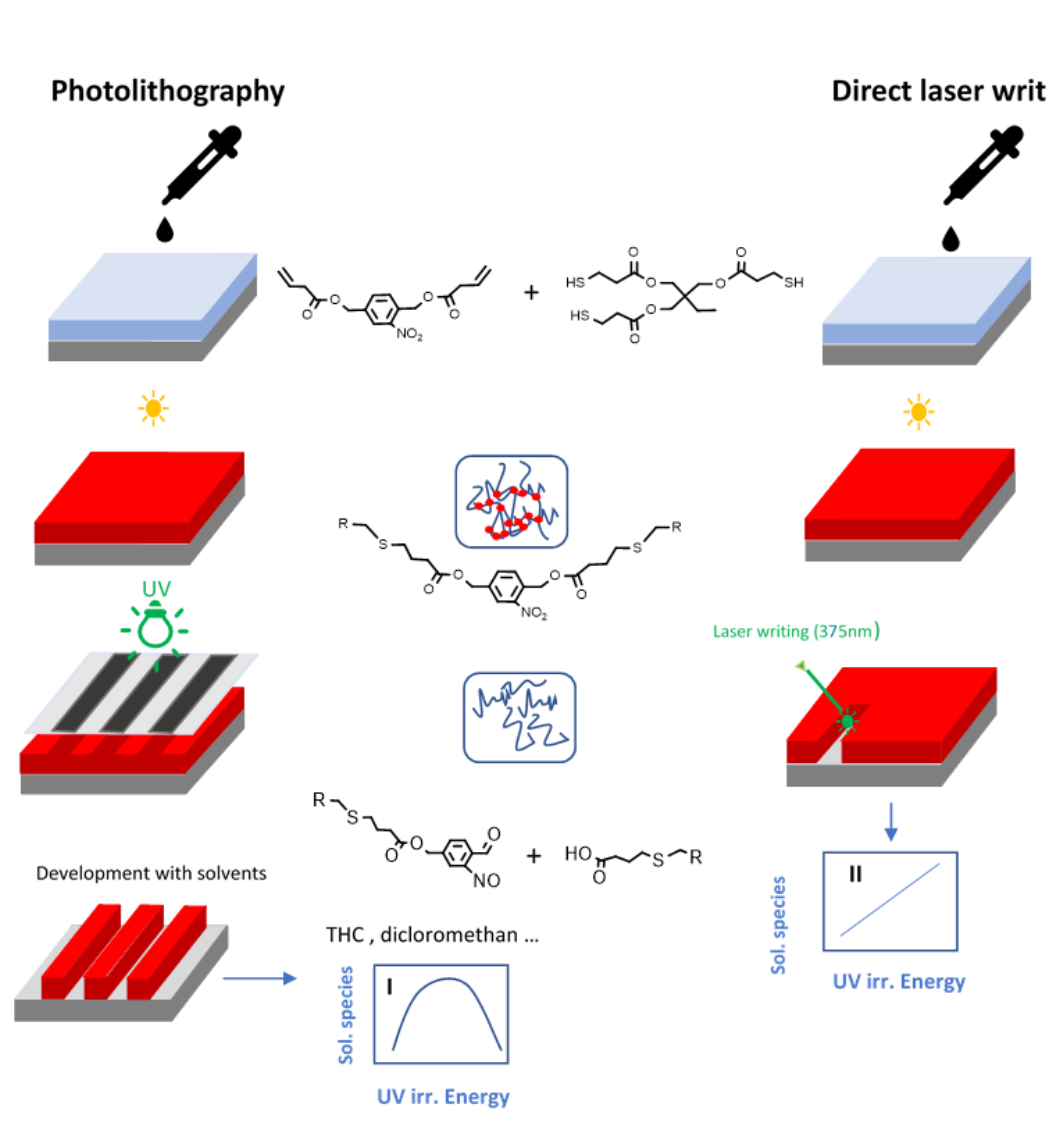
Figure 14. Comparison between photolithography and direct laser writing for the introduction of micropatterns in photosensitive thiol-ene networks (Reprinted with permission from reference [87]).